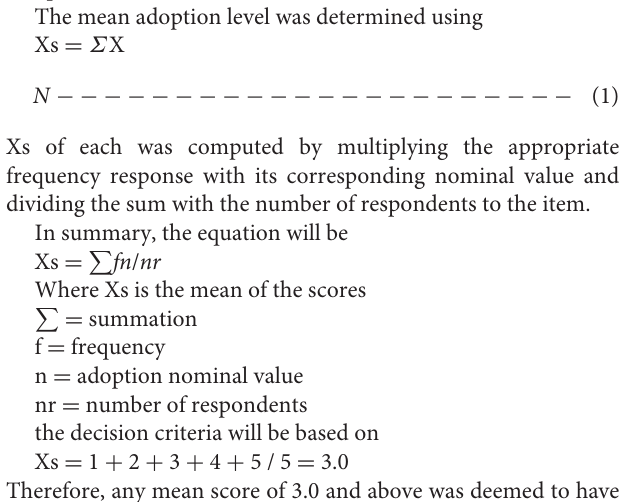
are Awareness (1), interest (2), Evaluation (3), trial (4), and accepted